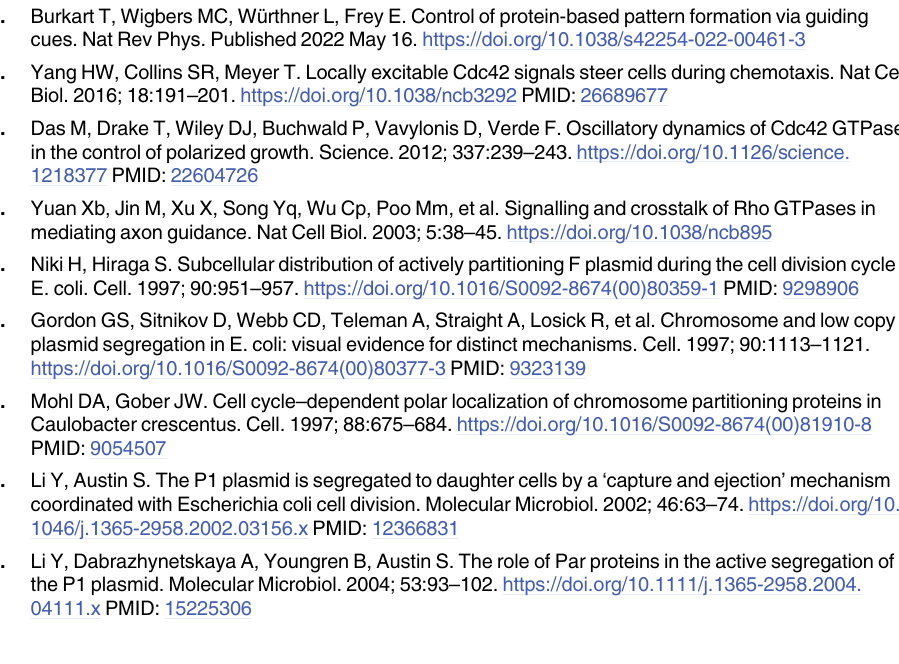
S1 Table. Model parameters capturing in vivo